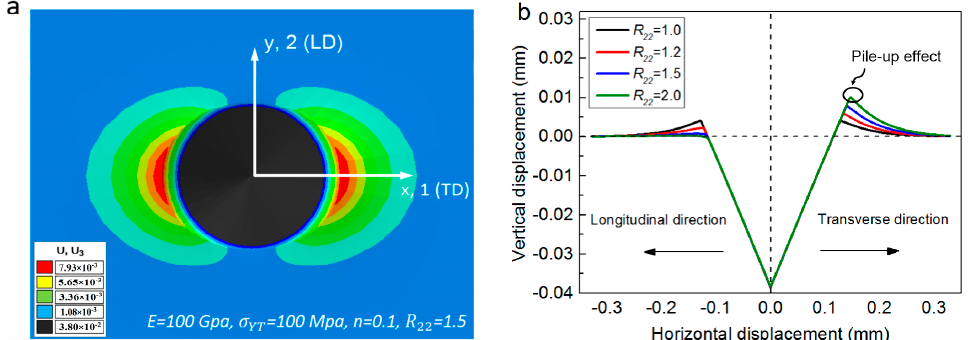
Figure 5. Influence of yield stress ratio R 22 on the surface deformation of anisotropic materials: ( a ) residual imprint mapping left on the surface of specimen after indenter withdrawal; ( b ) variation of the residual imprints along two orthogonal directions with R 22 increases.